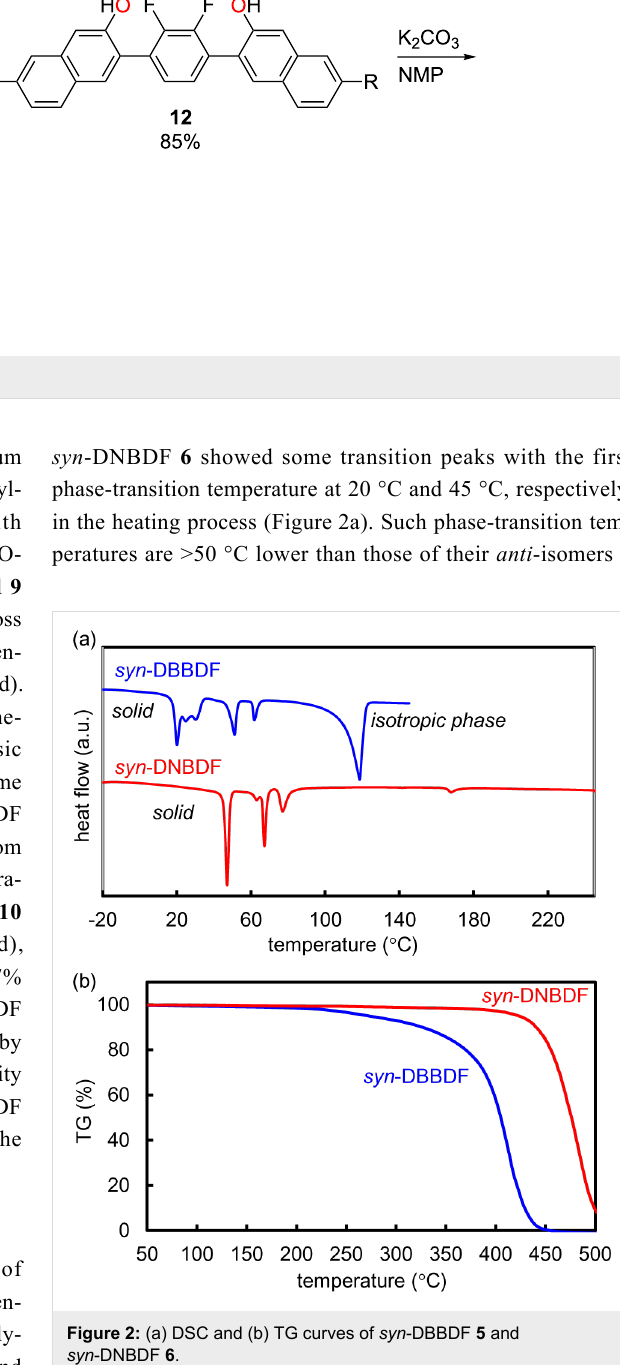
Figure 2: (a) DSC and (b) TG curves of syn -DBBDF 5 and syn -DNBDF 6 .